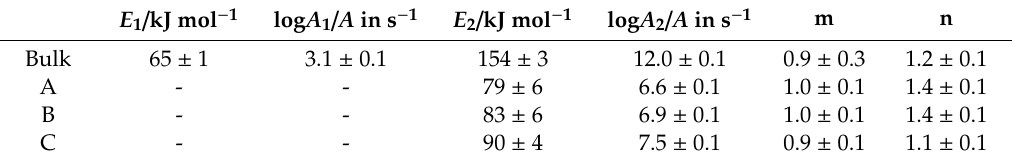
Table 2. Calculated kinetic parameters for bulk and confined polymerization of cyanate ester.